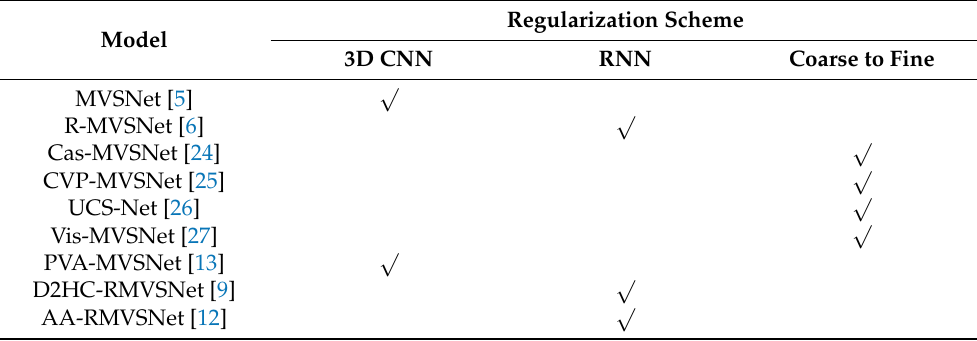
Table 1. Classification of learning-based MVS methods regularization scheme.